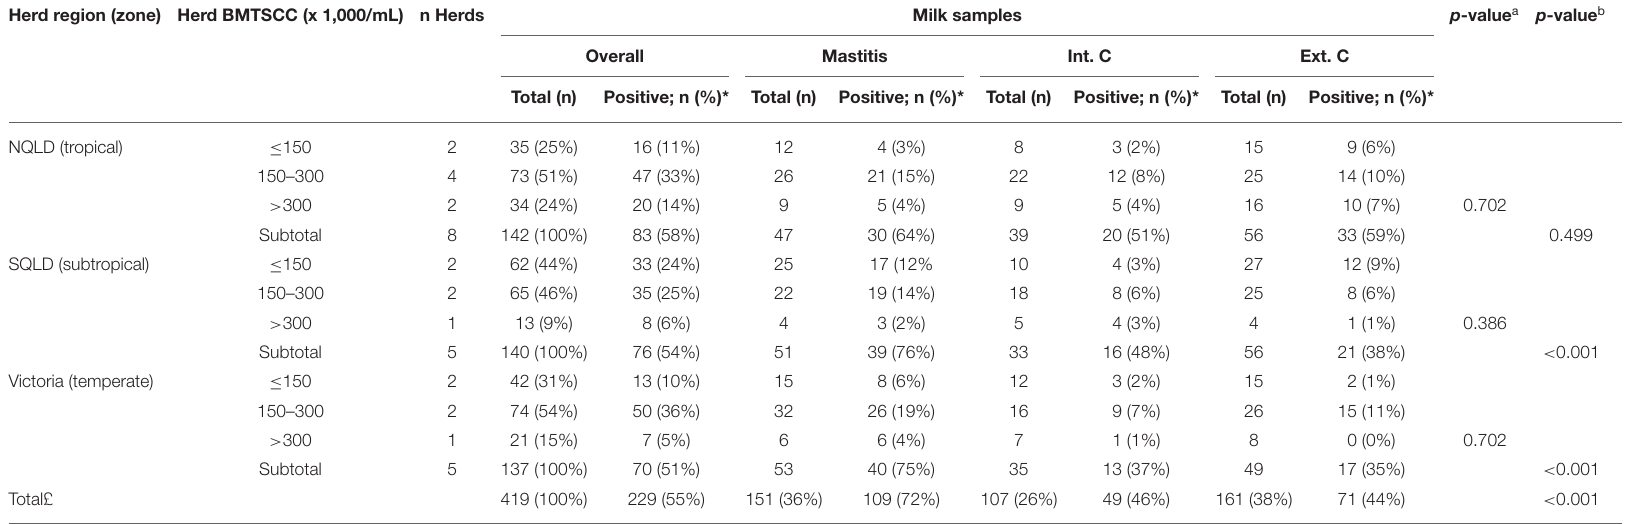
TABLE 1 | Distribution and percentage of milk samples and positive cultures for each sample type stratified by herd’s region and herd’s bulk milk tank somatic cell counts category (BMTSCC). Herd region (zone) Herd BMTSCC (x 1,000/mL) n